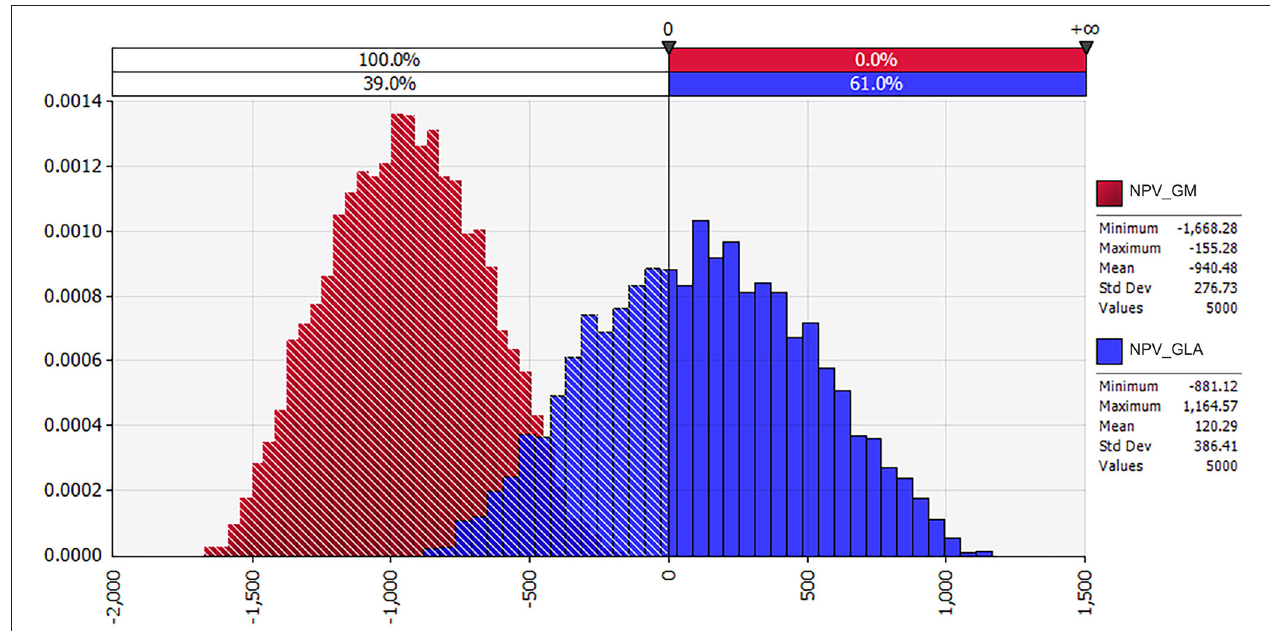
FIGURE 3 | Probability density distributions for NPV for the grass-legume association and the grass monoculture. GLA, Grass-legume association; GM, Grass